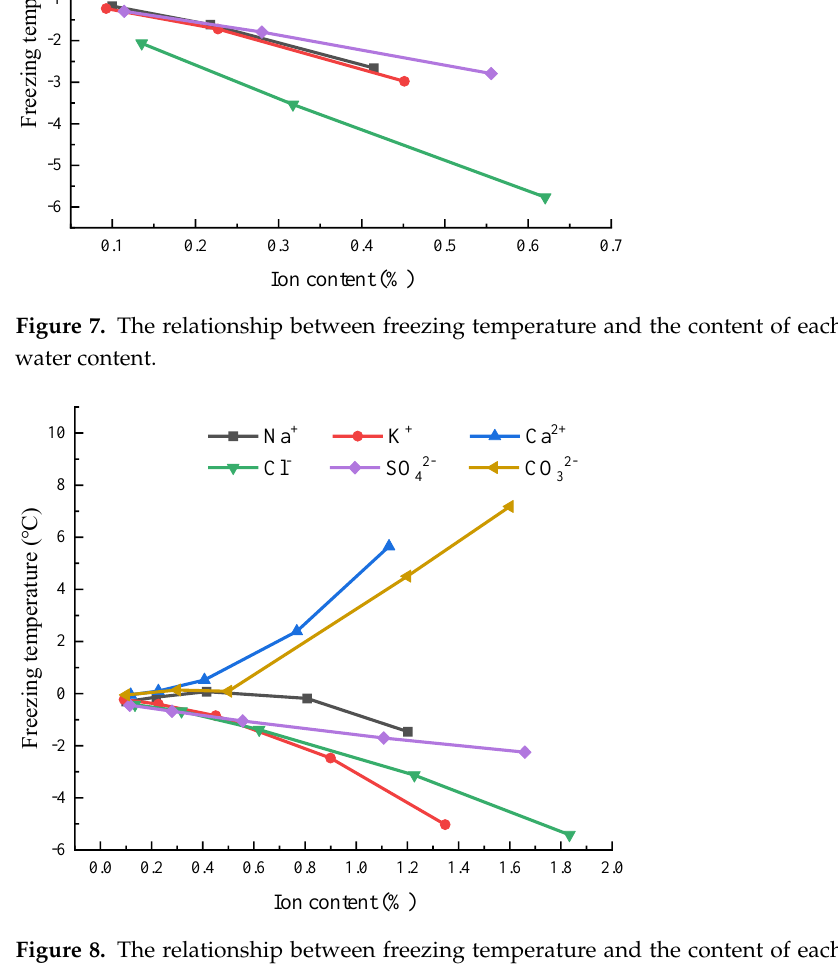
Figure 8. The relationship between freezing temperature and the content of each ion under 30% water content.